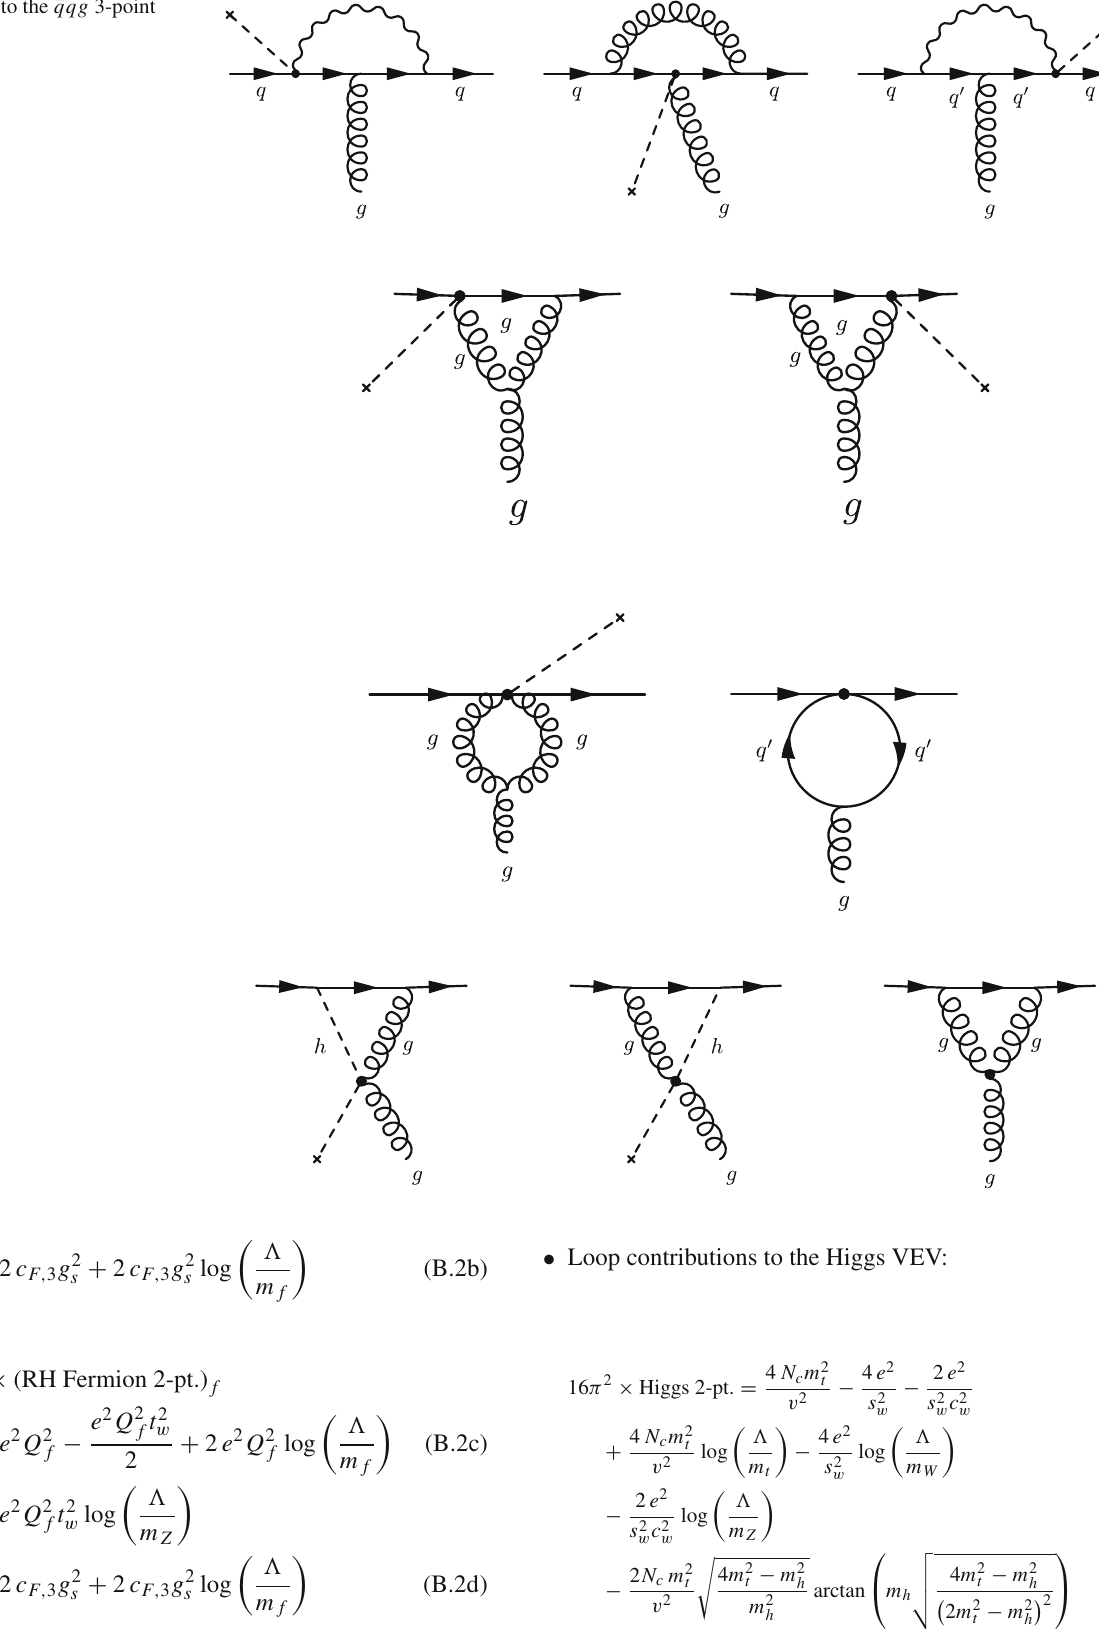
Fig. 14 1PI diagrams contributing to the ¯ qqg 3-point